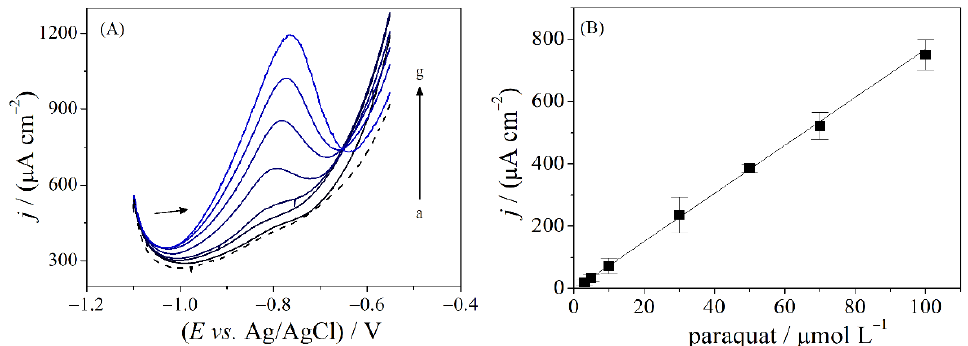
Figure 4. ( A ) Square-wave voltammograms obtained using the paper-based silver sensor in the absence (dashed line) and presence of different concentrations of paraquat (solid line: (a) 3.0 µmol L −1 , (b) 5.0 µmol L −1 , (c) 10.0 µmol L −1 , (d) 30.0 µmol L −1 , (e) 50.0 µmol L −1 , (f) 70.0 µmol L −1 , and (g) 100 µmol L −1 )) in 0.1 mol L −1 Na 2 SO 4 solution. ( B ) The respective analytical curve. SWV conditions: f = 3 Hz; a = 60 mV; Δ E = 2 mV.